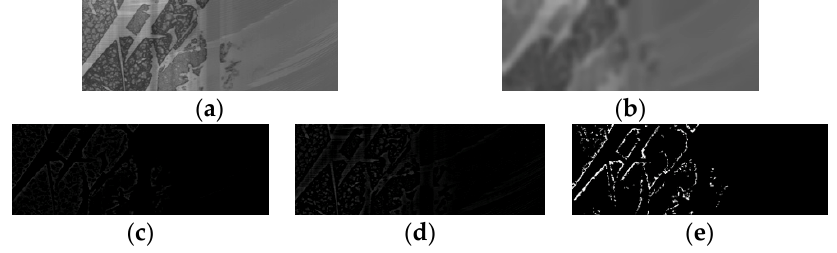
Figure 7. Difference of Gaussian of aluminum ingot image with a large-scale defect: ( a ) the original image; ( b ) the Gaussian blur effect; ( c ) the DoG response map calculated by Equation (8); ( d ) the DoG response map calculated by the opposite of Equation (8); ( e ) the binary image after thresholdsegmentation.